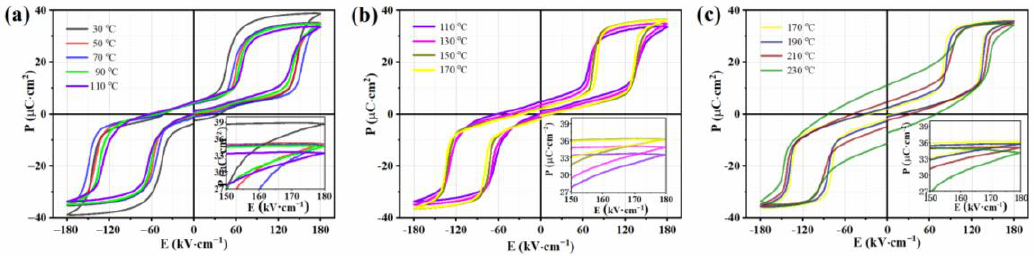
Figure 3. P-E loops of AgNbO 3 ceramics within the temperature range of 30~230 °C under 180 kV·cm −1 : ( a ) 30~110 °C, ( b ) 110~170 °C, ( c ) 170~230 °C.